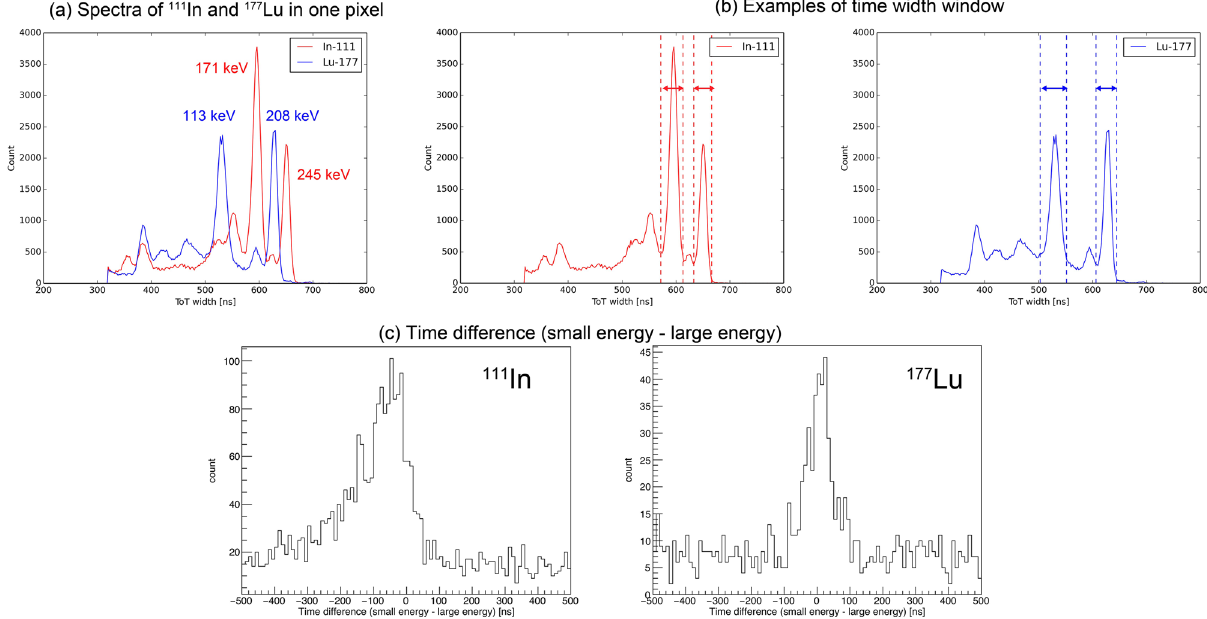
Figure 6. Spectra, examples of the time width window, and histogram of the time difference. ( a ) Spectra of 111 In and 177 Lu measured by 1 px of an HR-GAGG pixel detector. ( b ) Examples of the time width window for event selection. ( c ) Histograms of the time difference of 111 In and 177 Lu. A tail caused by the relatively long duration of 85 ns is shown in the 111 In